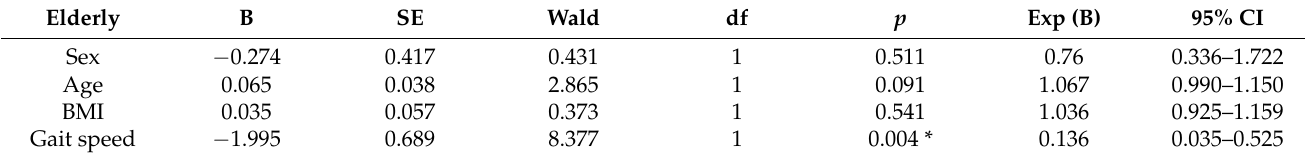
Table 5. Logistic regression analysis for risk factors of low visual acuity (L group) in elderly